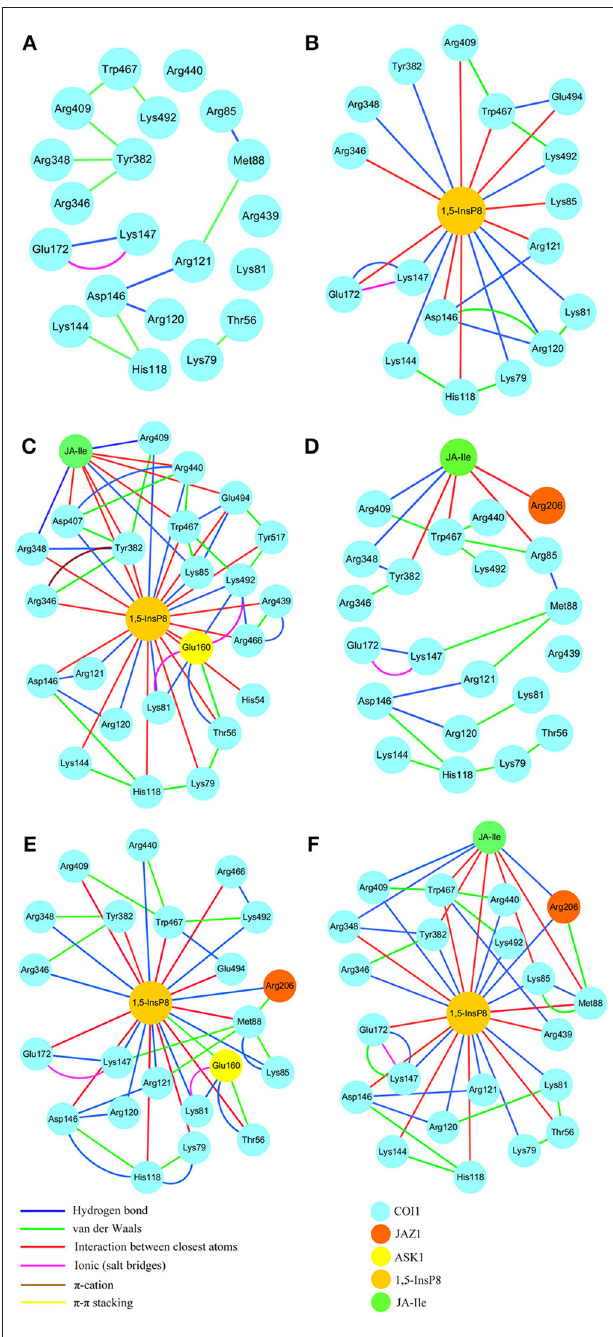
FIGURE 8 | The residue interaction network of amino acids within 5Å around 1,5-InsP 8 . (A) system 1, COI1 + ASK1, without 1,5-InsP 8 and JA-Ile, the residue interaction network in the cavity of COI1; (B) system 2, COI1 + ASK1 + 1,5-InsP 8, the residue interaction network between 1,5-InsP 8 and COI1; (C) system 3, COI1 + ASK1 + 1,5-InsP 8 + JA-Ile, the residue interaction network among 1,5-InsP 8 , JA-Ile and COI1; (D) system 4, COI1 + ASK1 + JAZ1 + JA-Ile, the residue interaction network in the cavity of COI1 and between JA-Ile and COI1; (E) system 5, COI1 + ASK1 + JAZ1 + 1,5-InsP 8 , the residue interaction network between 1,5-InsP 8 and COI1; (F) system 6, COI1 + ASK1 + JAZ1 + 1,5-InsP 8 + JA-Ile, the residue interaction network among 1,5-InsP 8 , JA-Ile, and